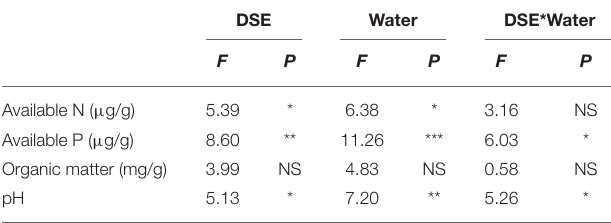
The * symbol indicates the significant difference, P < 0.05. The ** symbol indicates the significance level intervenes between P < 0.01. The *** symbol indicates the difference is very significant at P < 0.001.